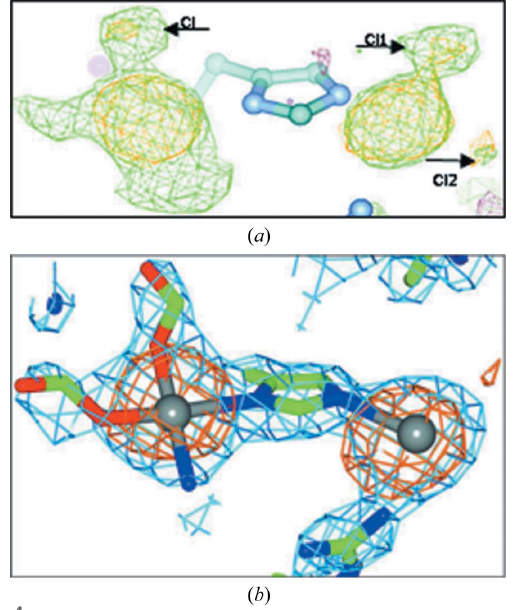
Figure 4 An example of the benefits of raw diffraction data sharing in macromolecular crystallography: avoiding the conversion of carboplatin to cisplatin at a high concentration of sodium chloride. ( a ) The partially converted carboplatin (Tanley, Diederichs et al. , 2013) and ( b ) alternative crystallization conditions led to the best study yet of carboplatin binding to histidine (Tanley et al. , 2014). Reproduced with the permission of the